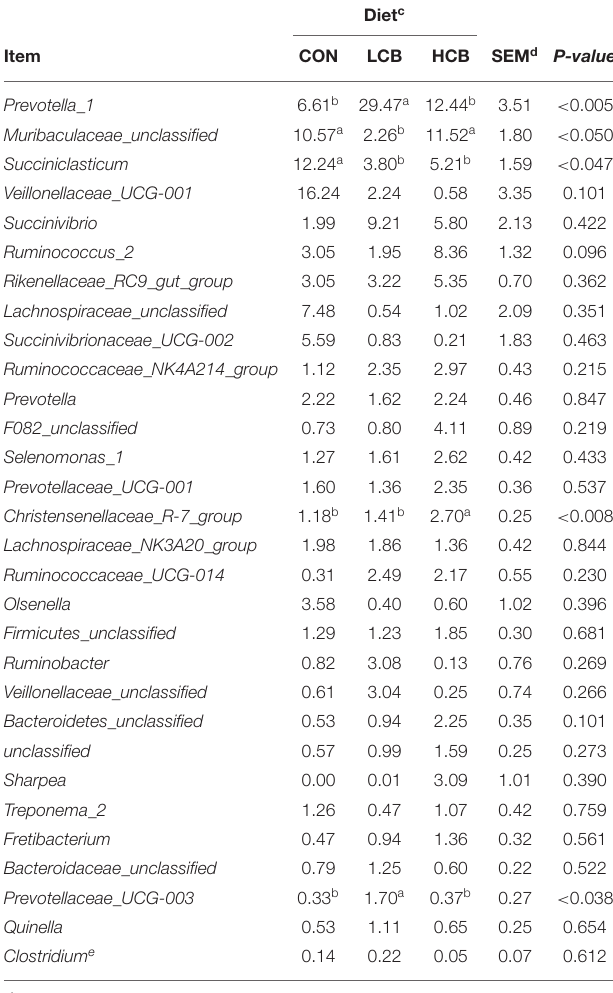
TABLE 6 | Effects of different doses of C. butyricum on phylum relative rumen microbiota abundances ( > 1.0%) of fattening goats. Diet a